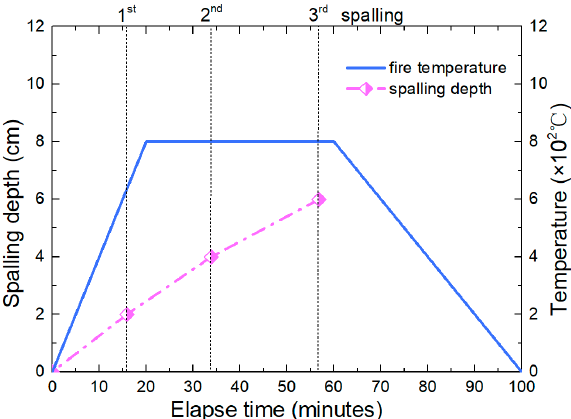
Figure 16. Spalling depth of tunnel lining with elapsed time.